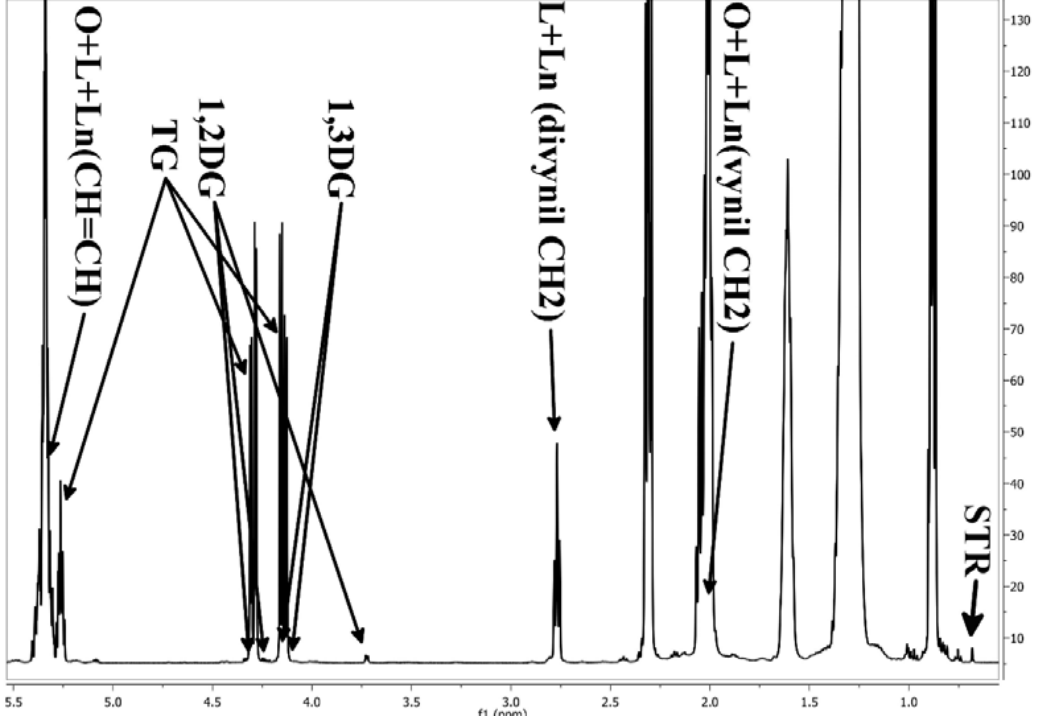
Figure 2. Main spectral region for the 1 H-NMR profile at 500 MHz of the CDCl 3 soluble fraction (PO) extracted from pistachio powder (sample from Bronte). Arrows display the main assignment connections, according to the symbol codes in Table 1, subsequently processed by MARA-NMR algorithm (see Table S3 for technical